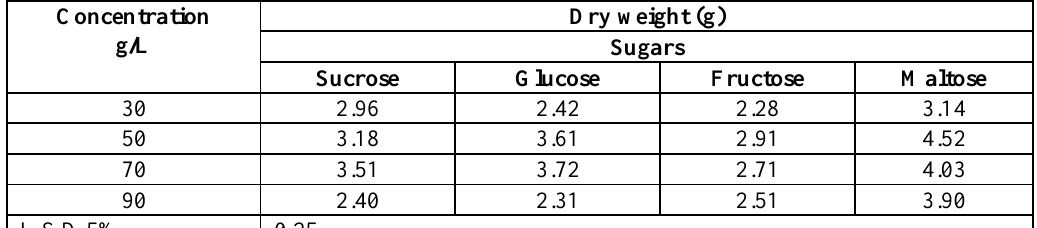
Table 5 :- Effect of different concentrations of the sugars with the presence of 0.5 mg/L TDZ and 2mg/L Cholesterol on the dry weight of multiplied shoots of Digitalis purpurea